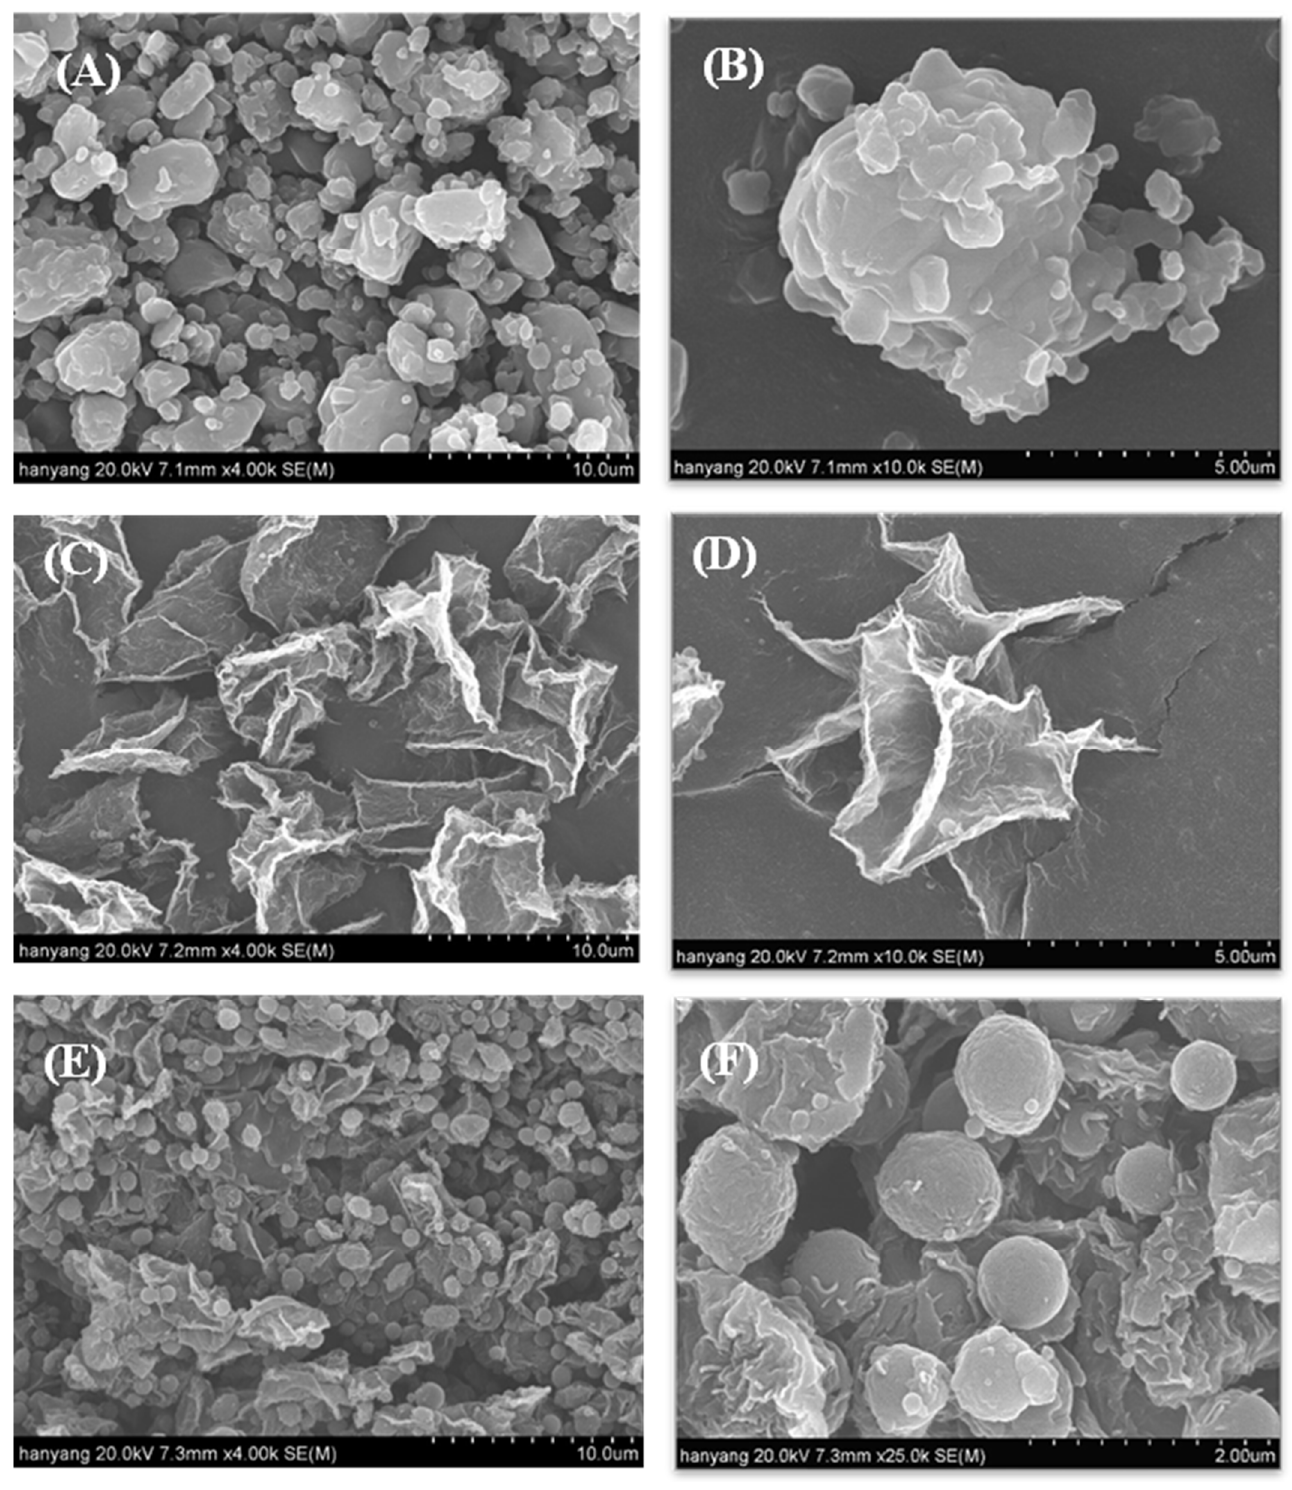
Figure 4. Scanning electron micrographs: ( A ) RXB powder (×4000); ( B ) RXB powder (×10,000); ( C ) PVA-based solid dispersions (×4000); ( D ) PVA-based solid dispersions (×10,000); ( E ) gelatin-based solid dispersions (×4000); and ( F ) gelatin-based solid dispersions (×25,000).